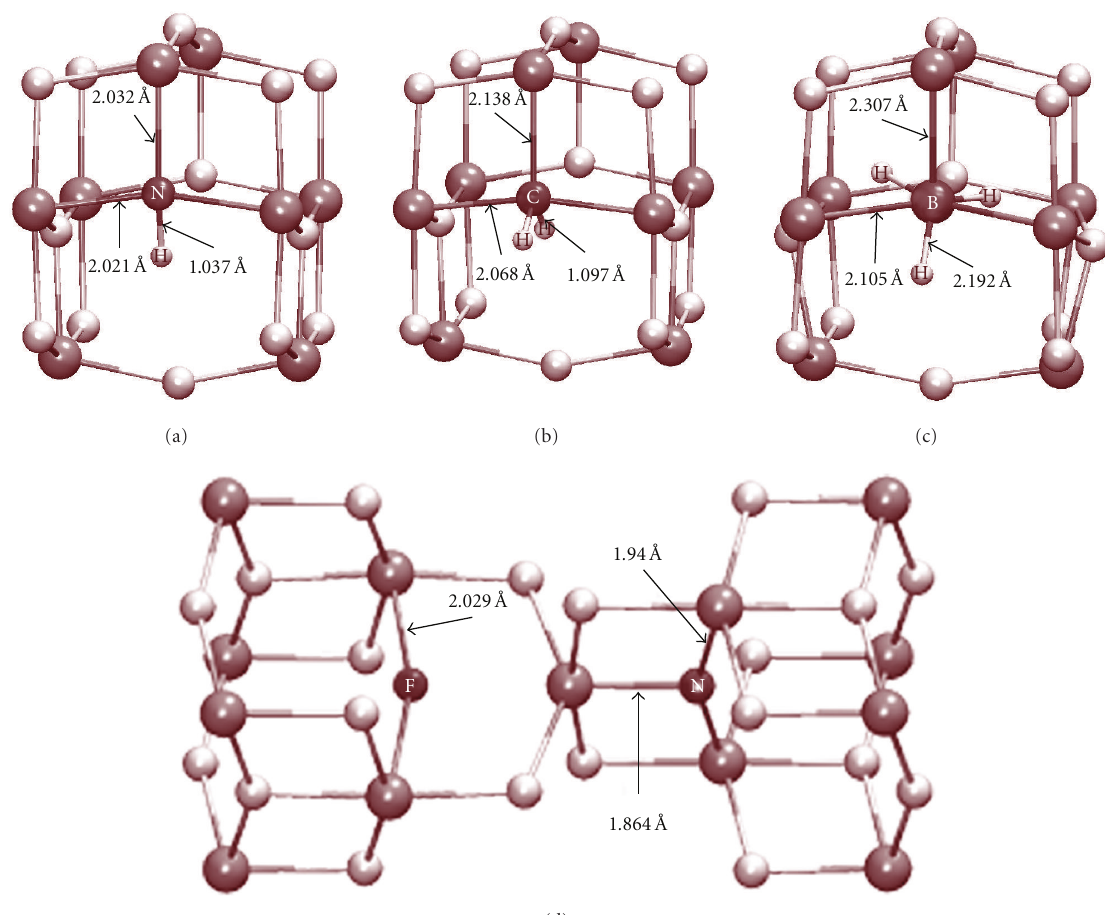
Figure 3: The optimal structures for (a) N :H-doped TiO 2 , (b) C:2H-doped TiO 2 , (c) B:3H-doped, and (d) N:F codoped TiO 2